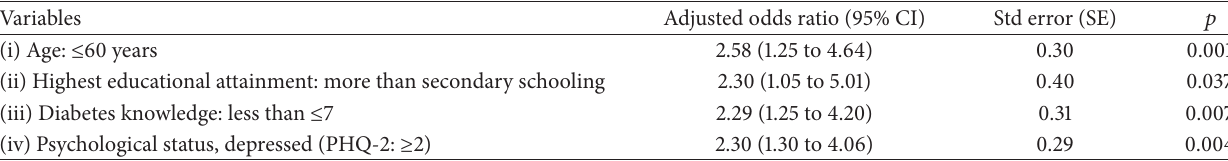
Table 4: Predictors of low diabetes self-management in T2DM patients ( 𝑛 = 224